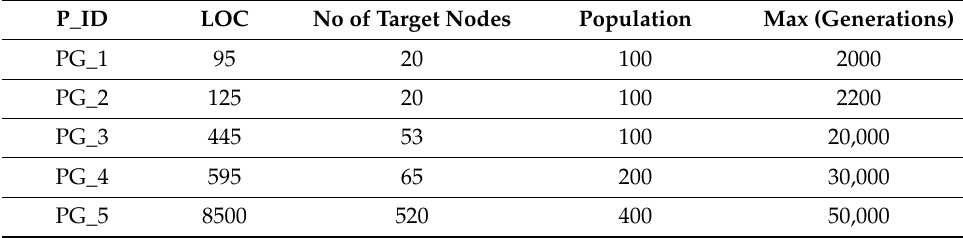
Figure 7. Comparison of execution time of AGA and random method. Table 4. Parameter setting for the industrial trial